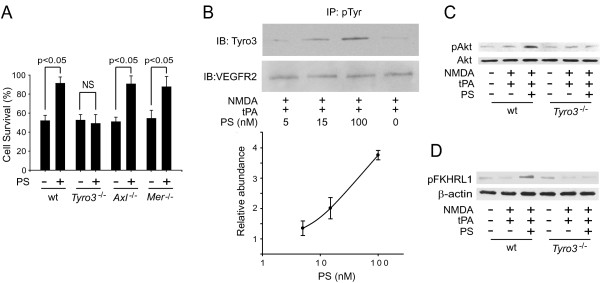
PS neuroprotection requires Tyro3 activation. (A) Cell survival of cortical neurons isolated from Tyro3, Axl or Mer null mice and wild type (wt) mice after 24 h of tPA/NMDA exposure in the presence or absence of PS. Cell survival was quantified with a WST-8 assay. (B) PS dose-dependently mediates Tyro3 tyrosine phosphorylation in tPA/NMDA-treated mouse cortical neurons as determined by immunoprecipitation (IP) with anti-phospho-tyrosine (pTyr) antibody followed by immunoblotting (IB) with anti-Tyro3 antibody and anti-VEGFR2 (vascular endothelial growth factor receptor 2) antibody (as a loading control) 2 h after tPA/NMDA. Graph, relative abundance of phosphorylated Tyro3 to VEGFR2. (C) Akt phosphorylation (pAkt, Ser473) in neurons isolated from Tyro3 null mice and wt controls exposed to tPA/NMDA for 2 h in the presence or absence of PS. (D) FKHRL1 phosphorylation (pFKHRL1, Ser253) in neurons isolated from Tyro3 null mice and wt controls exposed to tPA/NMDA for 4 h in the presence or absence of PS. In all studies murine PS was used at 100 nM unless specified and was added simultaneously with tPA/NMDA. Mean ± SEM, n = 3 independent cultures in triplicate. NS, non-significant.